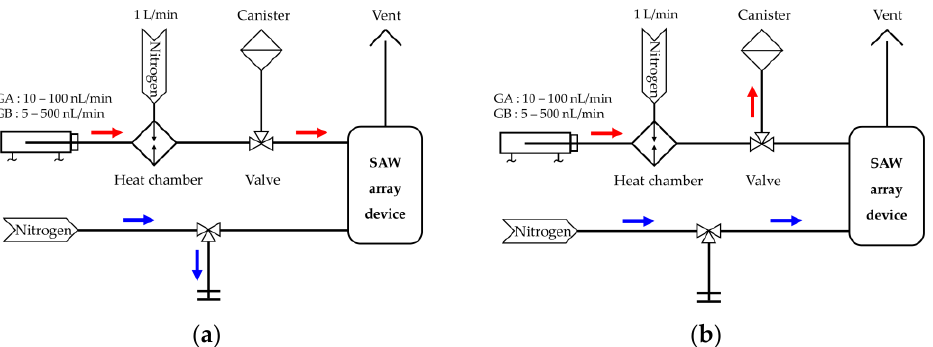
Figure 4. Schematic diagram of the experimental setup for testing the SAW array device with nerve agents (TNO, Netherland): ( a ) exposure to G nerve agents; ( b ) exposure to N 2 gas for purging.